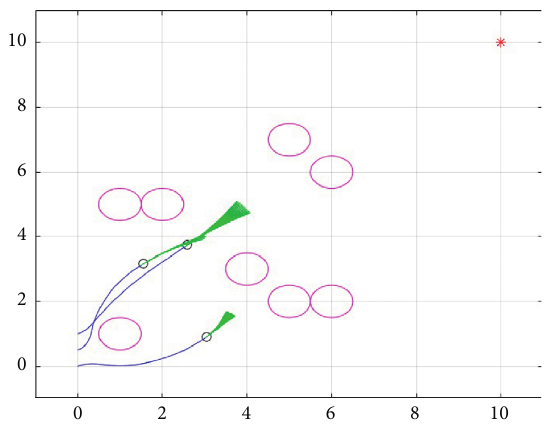
Figure 13: The positions of the robots: t � 10s.